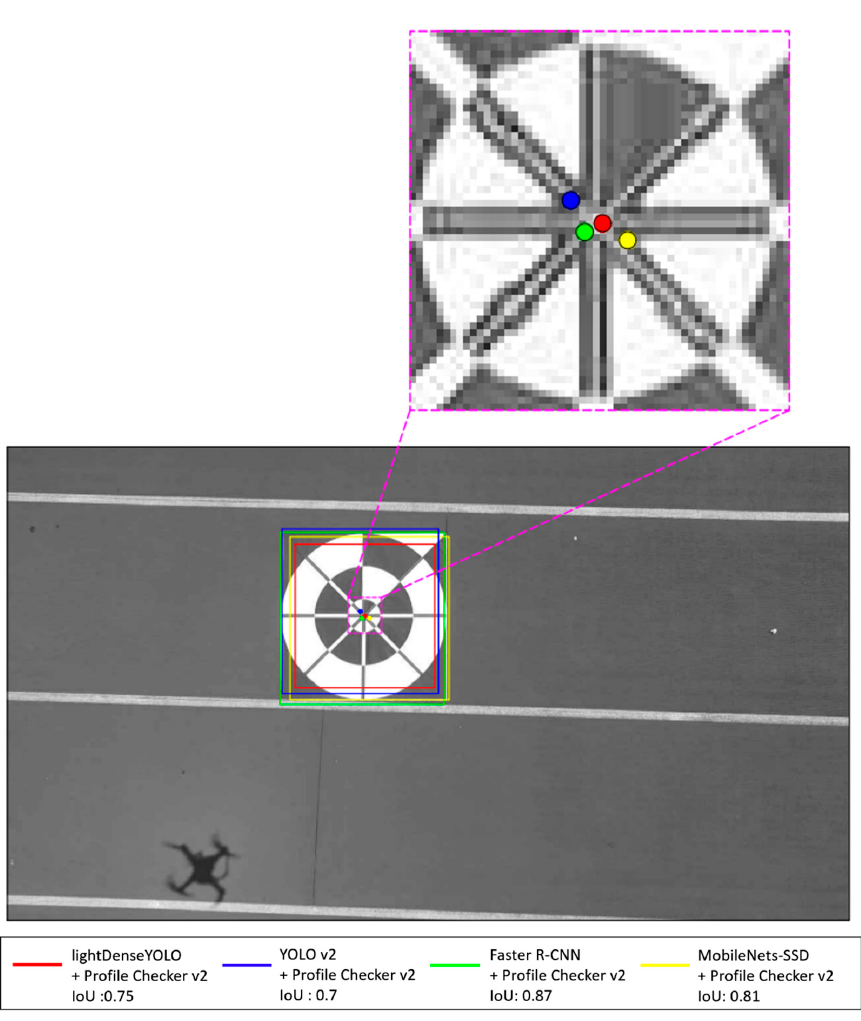
Figure 15. Example of detected marker at close distance image.